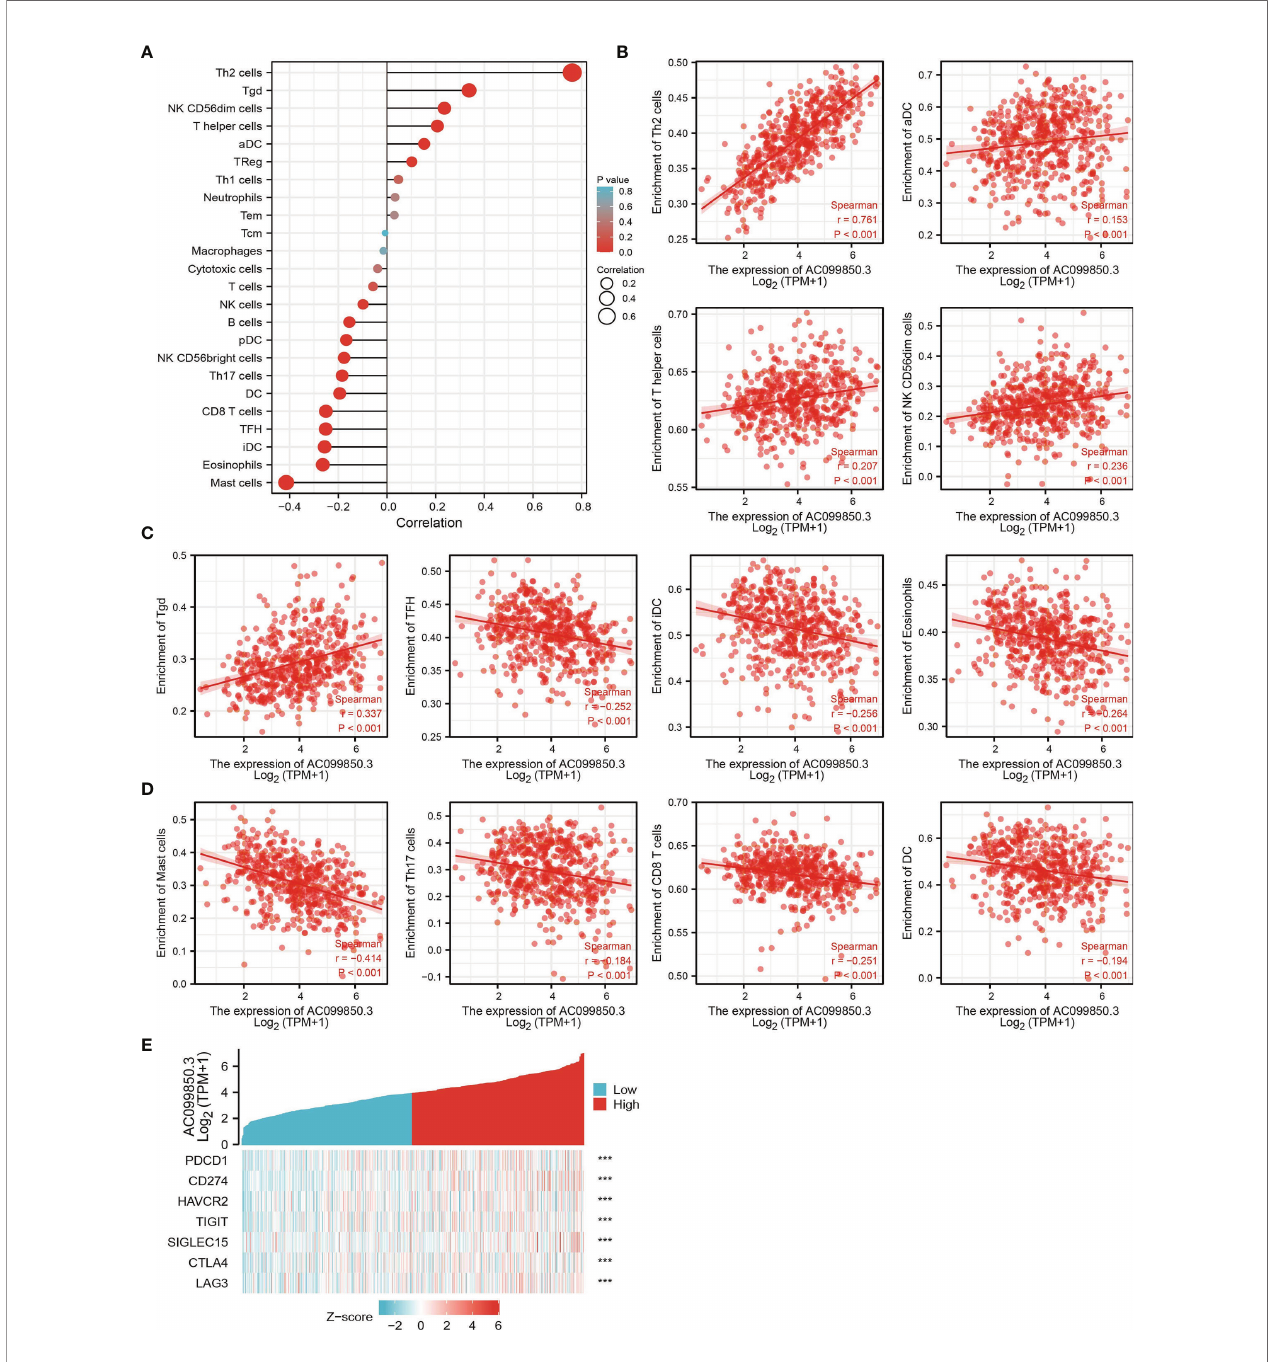
FIGURE 7 | Correlation analysis of AC099850.3 expression and in fi ltration levels of immune cells in LUAD. (A – D) The correlation between AC099850.3 expression and the in fi ltration levels of 24 immune cells in LUAD. (E) The correlation between AC099850.3 expression and immune checkpoint-related genes in LUAD. ***P <